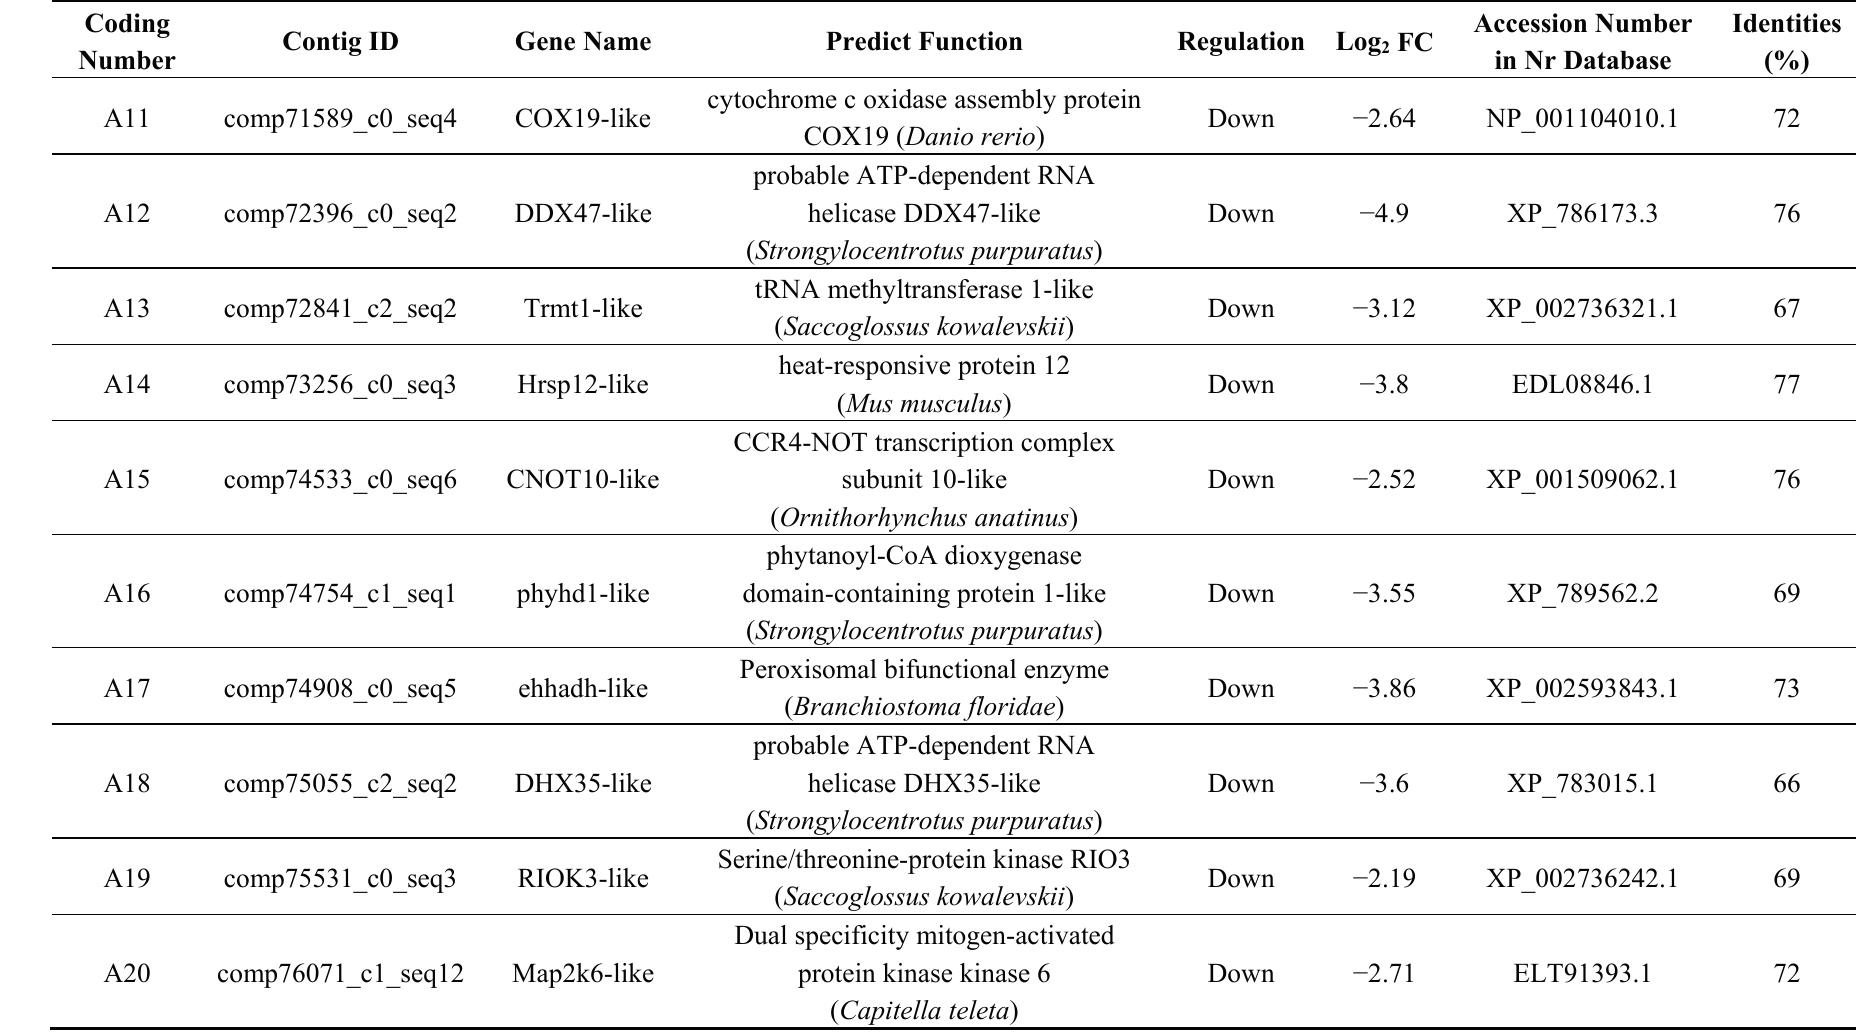
Table 5. Other putative disease-resistant